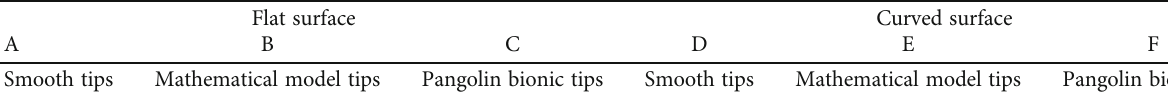
Table 3: Subsoiler shovel tip design.